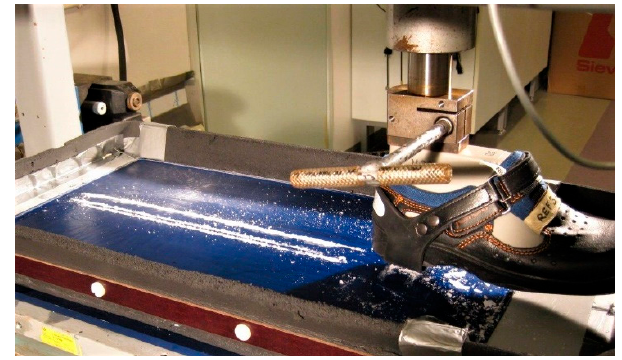
Figure 2. The dynamic coefficient of friction (DCOF) measuring method.